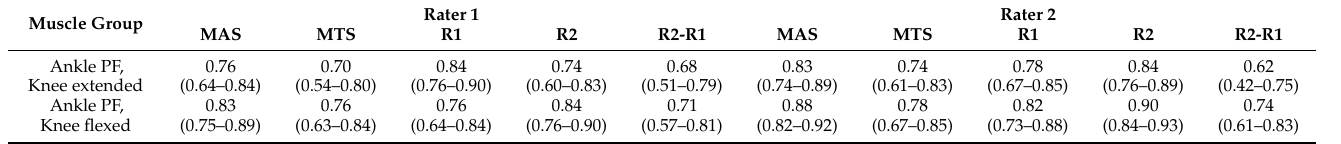
Table 3. Intra-rater reliability of the Modified Ashworth Scale and Modified Tardieu Scale.